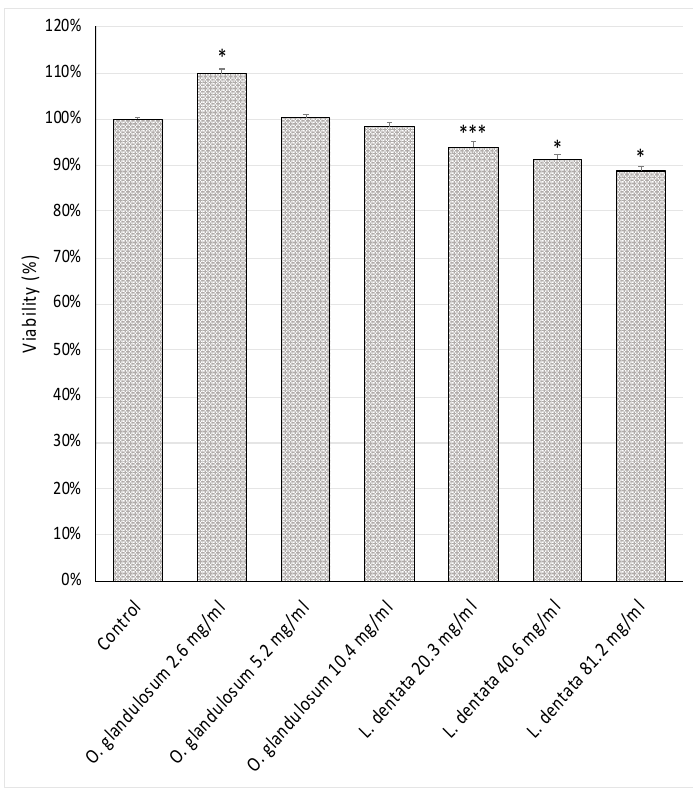
Figure 3. Effect of essential oils of L. dentata and O. glandulosum on the cell viability of human lym- phocytes (MTT test): viability (%) of human lymphocytes (1 × 10 6 cells/mL) incubated with medium alone (control), Origanum (2.6, 5.2, and 10.4 mg/mL) and Lavandula (20.3, 40.6, and 81.2 mg/mL) for 24 h. Statistical analysis was performed by one-way ANOVA followed by Tukey’s test (* p < 0.05; ** p < 0.01; *** p < 0.001).